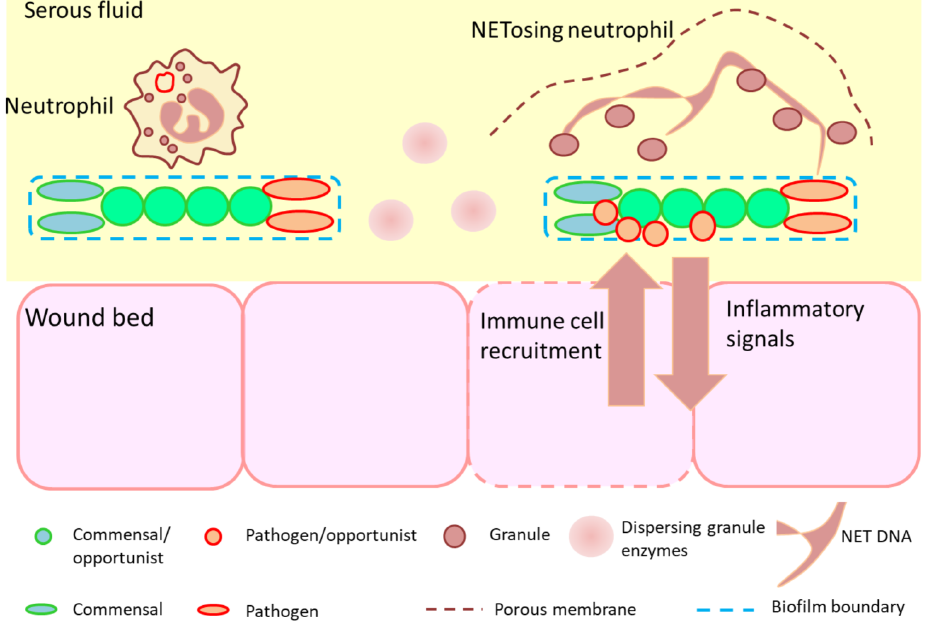
Figure 5. Biofilm stimulates a hyper-inflammatory immune response, leading to lysis, leakage and release of granular enzymes that are destructive to host tissue. Biofilm either develops at the wound site or may originate from biofilm fragments shed from other sources [104]. Neutrophils respond to biofilm in a manner analogous to parasite responses, namely, to lyse at the interface and form NETs, in which the neutrophil DNA is spread over the object surface to distribute granules and place them at the interface. The granules then release their enzymes onto the surface where they can potentially degrade the matrix. In most biofilms, this is ineffective and tends to only release proteases to the surrounding tissue and add DNA to the biofilm agglomeration where it is often used by the biofilm organisms themselves as EPS. This general scheme illustrates how both lysis of immune cells and NETosis lead to the release of host enzymes in the extracellular space [98 – 103,105]. Both the biofilm response and the lytic response to planktonic or isolated pathogens are associated with the release of neutrophil contents [106]. With increasing infection,